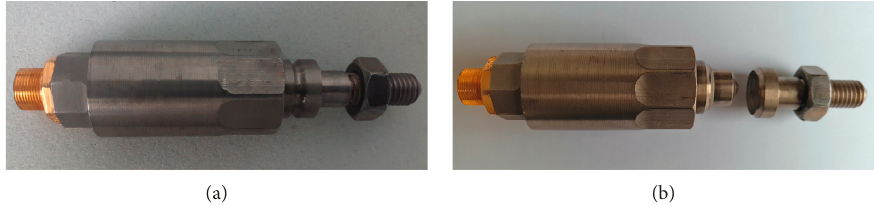
Figure 2: Photographs of the explosive bolt (a) before and (b) after separation.